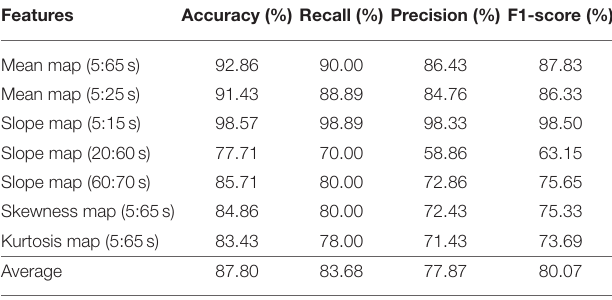
TABLE 8 | Convolutional neural network classification results of neuroimaging with temporal-spatial features for the Stroop task. Features